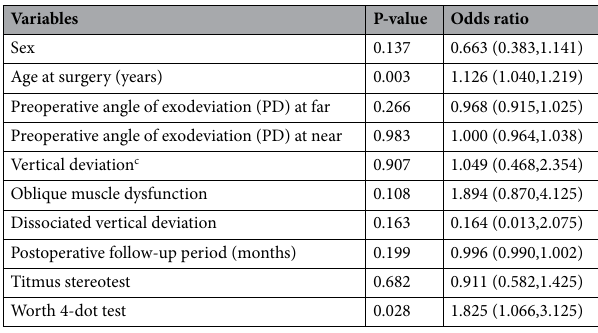
Table 5. Logistic regression analysis of surgery success and clinical